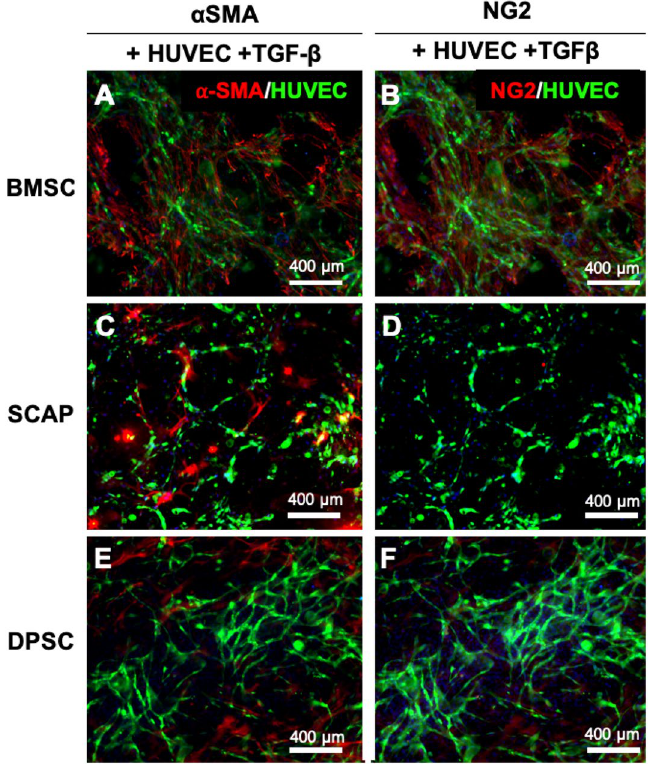
Figure 6. Early marker (NG2) and late marker (α-SMA) staining of differentiated stem cells with pericyte inducer TGF-β. The effect was identical with that of stem cell system involving no TGF-β. The BMSC showed the distribution of both cells ( A , B ), while DPSC ( C , D ) and SCAP ( E , F ) showed marked absence of NG2 positive cells.